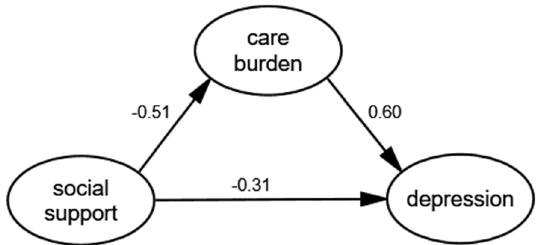
Figure 2. The final model and standardized model paths.